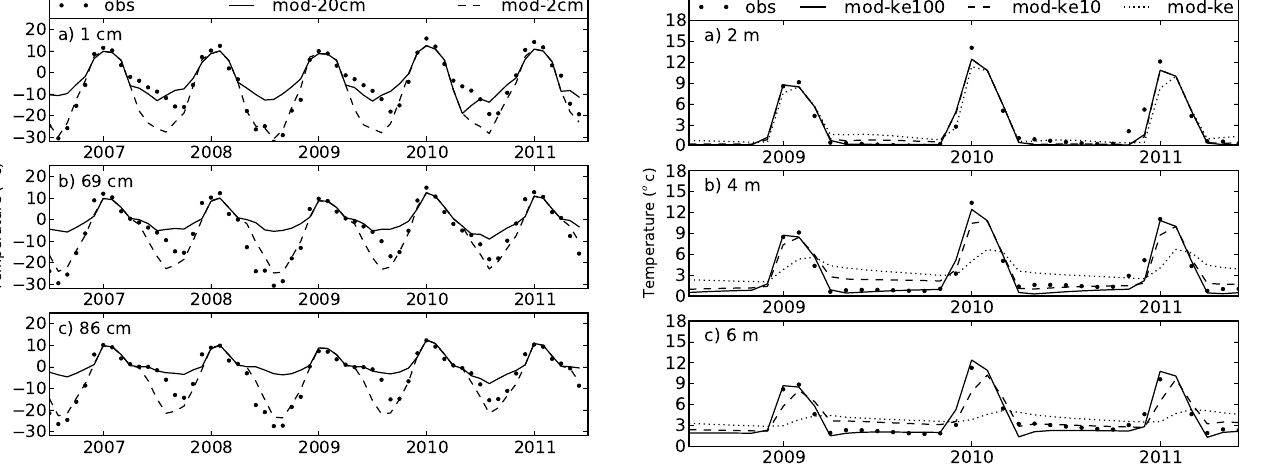
Figure 9. Comparisons of monthly average water temperatures at 2 (a) , 4 (b) and 6m (c) below the water surface at the lake site from simulations (mod) using default, 10, and 100 times the eddy diffusion coefficient (ke, ke10, and ke100), with field measurements (obs) over the period from 2009 to